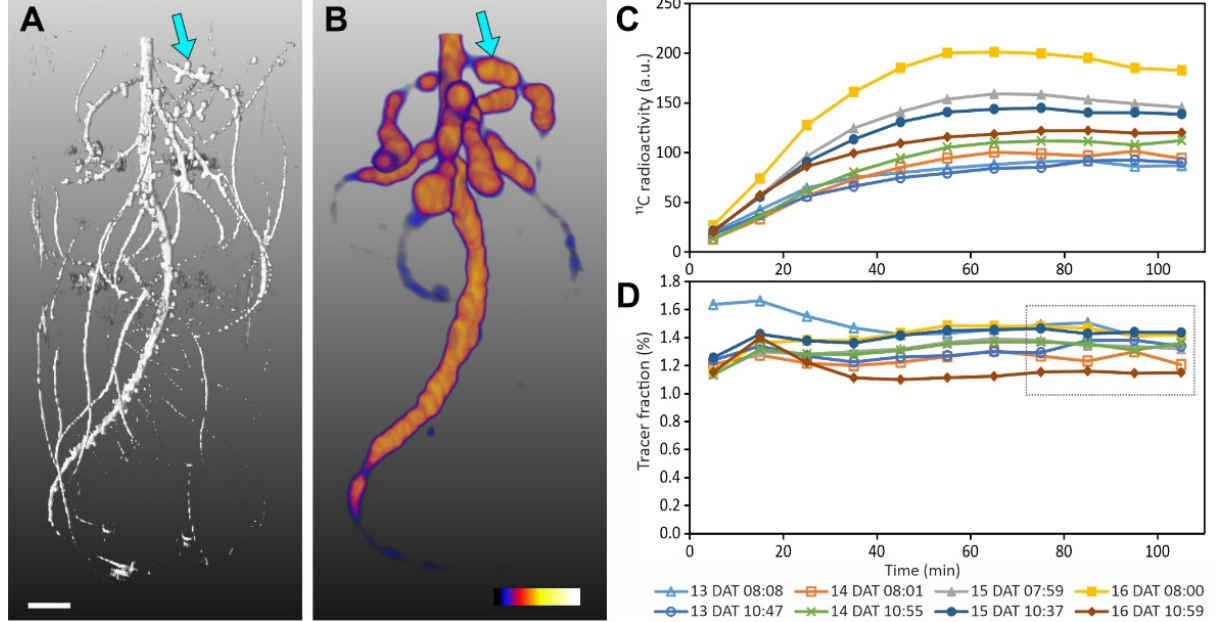
Figure 3. Root system of a pea plant visualized by Magnetic resonance image (MRI) and Positron Emission Tomography (PET) with corresponding time series of 11 C tracer in one nodule ROI. ( A ) MRI shows the structure of a nodulated root system 16 days after transfer to the pots (DAT, see Methods). The arrow indicates an individual nodule for which data are shown in ( C , D ). Scale bar, 10 mm. ( B ) PET image of 11 C tracer distribution within the nodulated root system 13 DAT (maximum intensity projection). Color scale 0.0 (black)–1.0 (white) a.u. The arrow indicates the same nodule as in ( A ). ( C ) Time series of decay corrected 11 C radioactivity in the region of interest (ROI) of the nodule marked by the arrow in B for all eight consecutive measurements, i.e., two measurements per day on 13, 14, 15, and 16 DAT. ( D ) Time series of radioactivity in the same ROI normalized to the total radioactivity detected in the root system. Note that 15 DAT 07:59 is partly covered by almost identical curve of 14 DAT 10:55. The grey box indicates the data points used to calculate mean tracer fractions for each measurement of this ROI.